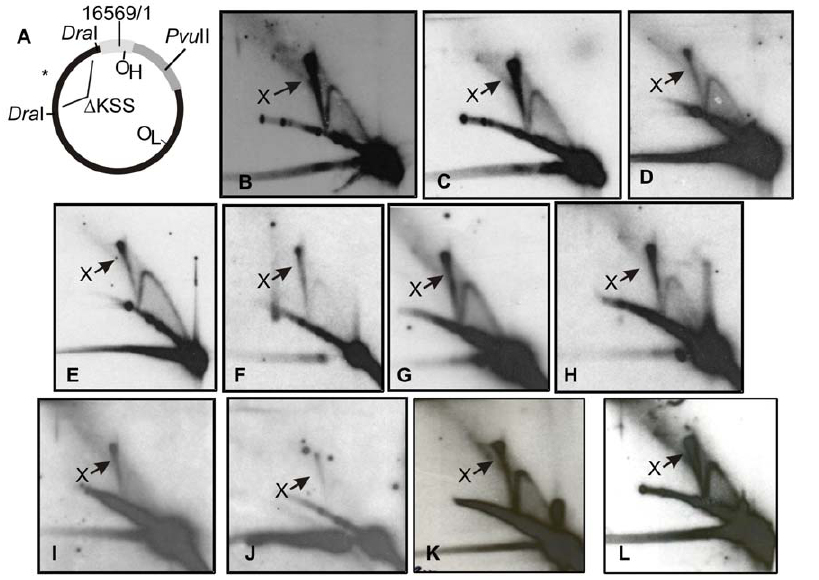
Figure 3. No qualitative change mtDNA replication and recombination intermediates in diseased human hearts. All analyzed samples retained the typical strong X-arc (X) and showed no evidence of ribonucleotide-incorporating replication intermediates. (A) A diagram of human mtDNA showing the analyzed Dra I ND5 probed fragment as earlier, followed by 2D-AGE panels of this representing (B) a male 46 years, acute ischemia, (C) male 84 years, chronic ischemia, (D) male 46, hypertrophic cardiomyopathy, (E) female 24, dilating cardiomyopathy, (F) mitochondrial cardiomyopathy, m.14709 T . C mutation, (G) mitochondrial cardiomyopathy (m.7472Cins + m.7472A . C), (H) m.3243A . G MELAS, (I) PolG (p.G848S/ p. S1104C) mutation, (J) KSS ( , 4.0 kb single mtDNA deletion, see also Figure S1), (K) a healthy control male, 19 years and (L) a healthy control female, 83 years.